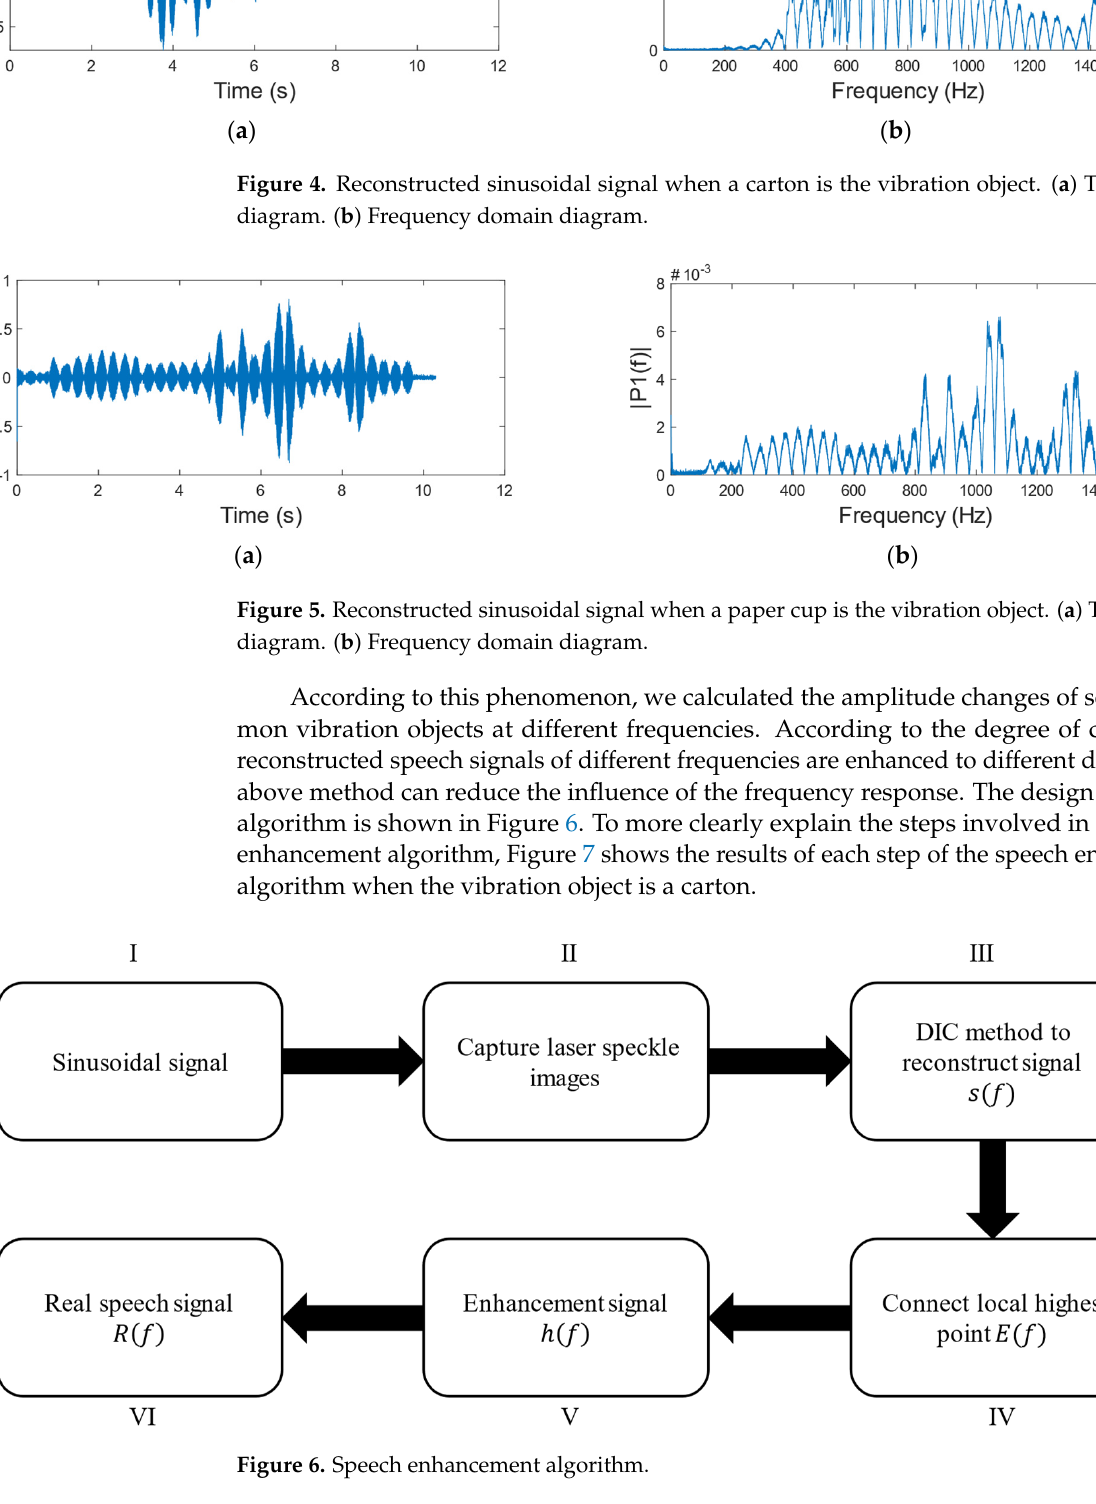
Figure 7. The process of speech enhancement when the vibration object is a carton. I.